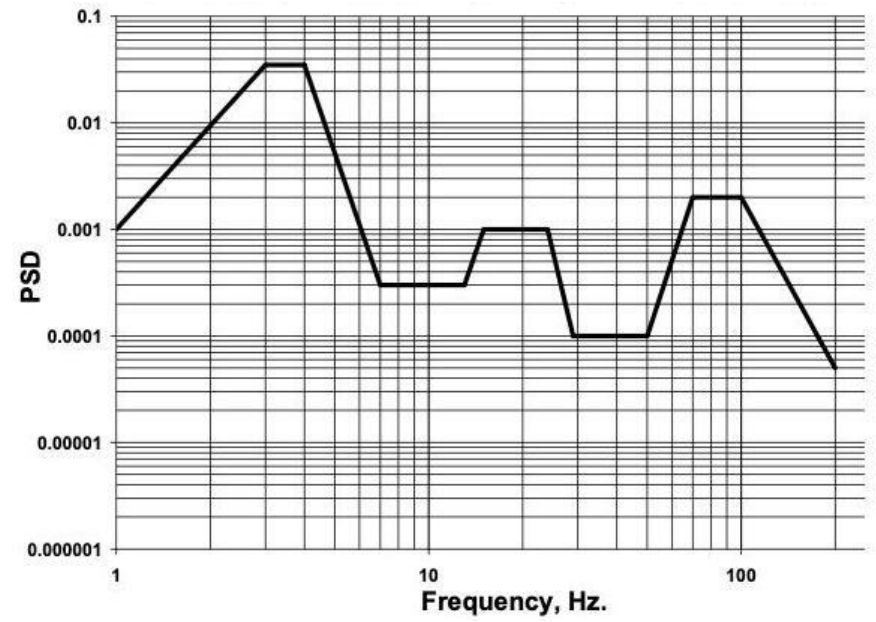
Figure 5. ASTM D7386—Standard Practice for Performance Testing of Packages for Single Parcel Delivery Systems PSD spectrum.